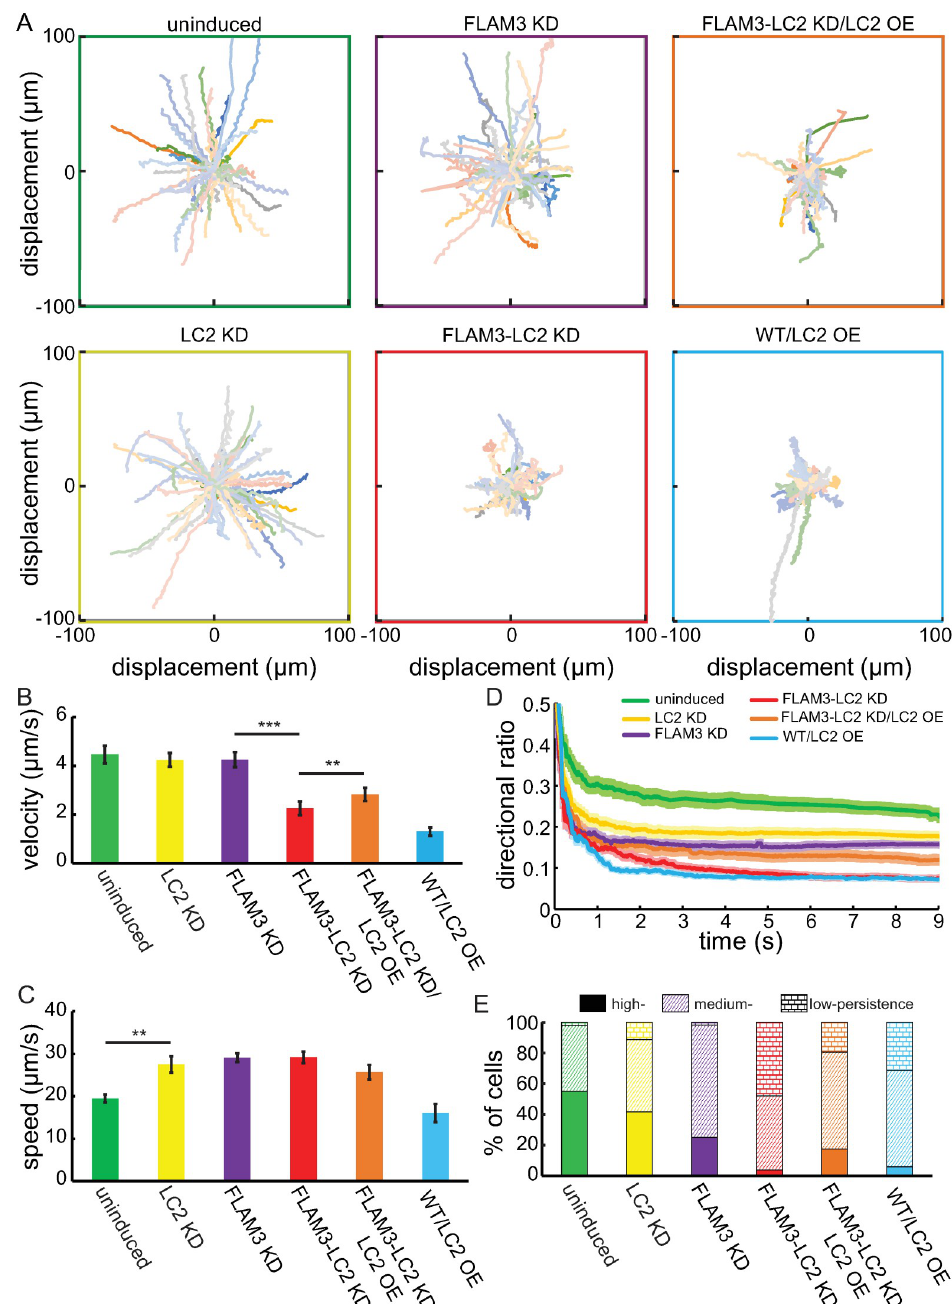
Fig 6. LC2 knockdown trypanosome cells have non-processive swimming behaviors. A . Swimming trajectories of trypanosome cells plotted from an initial position at the origin. Each trajectory represents 10 seconds of tracked data. B . Magnitude of the average velocity ( j ~ v j ¼ j D ~ r j , Materials and methods) of swimming trypanosome cells. C . Mean D t average swimming speed ( s ¼ L , Materials and methods) measured for multiple cell lines over the entire trajectory of D t 10 s. Error bars represent the SE of the mean, ��� corresponds to p -values < 0.0001, and �� corresponds to p - values < 0.003, two-tailed paired t -tests, in panels A. and B. D . The mean directional ratio (DR, dark lines) calculated over elapsed time and averaged for each strain. Error bars (lightly shaded bands) represent the SE of the mean. E . The percentage of cells that exhibit high persistence (DR > 0.2, solid color), medium persistence (0.05 < DR < 0.2, hatch mark), and low persistence (DR < 0.05, brick pattern), as determined by the last point (as time goes to infinity) directional ratio. We showed paths for and calculated values from N = 50, 75, 53, 73, 47, and 68 for uninduced, LC2 KD, FLAM3 KD, FLAM3-LC2 KD, FLAM3-LC2 KD/LC2 OE, and WT/LC2 OE cells, respectively, in all panels.